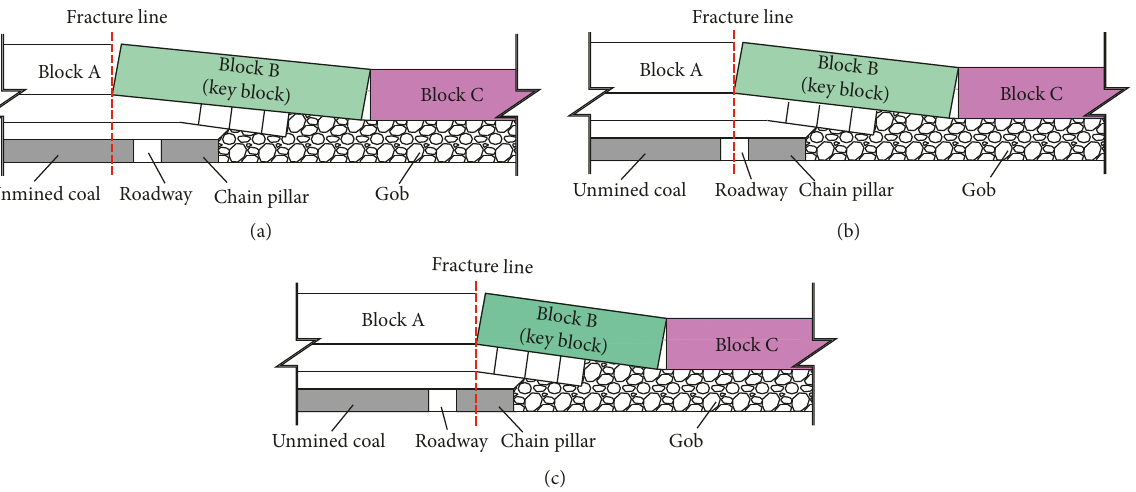
Figure 9: Structure of the lateral main roof. (a) Fracture line on the unmined coal side. (b) Fracture line above the roadway. (c) Fracture line on the chain pillar side.